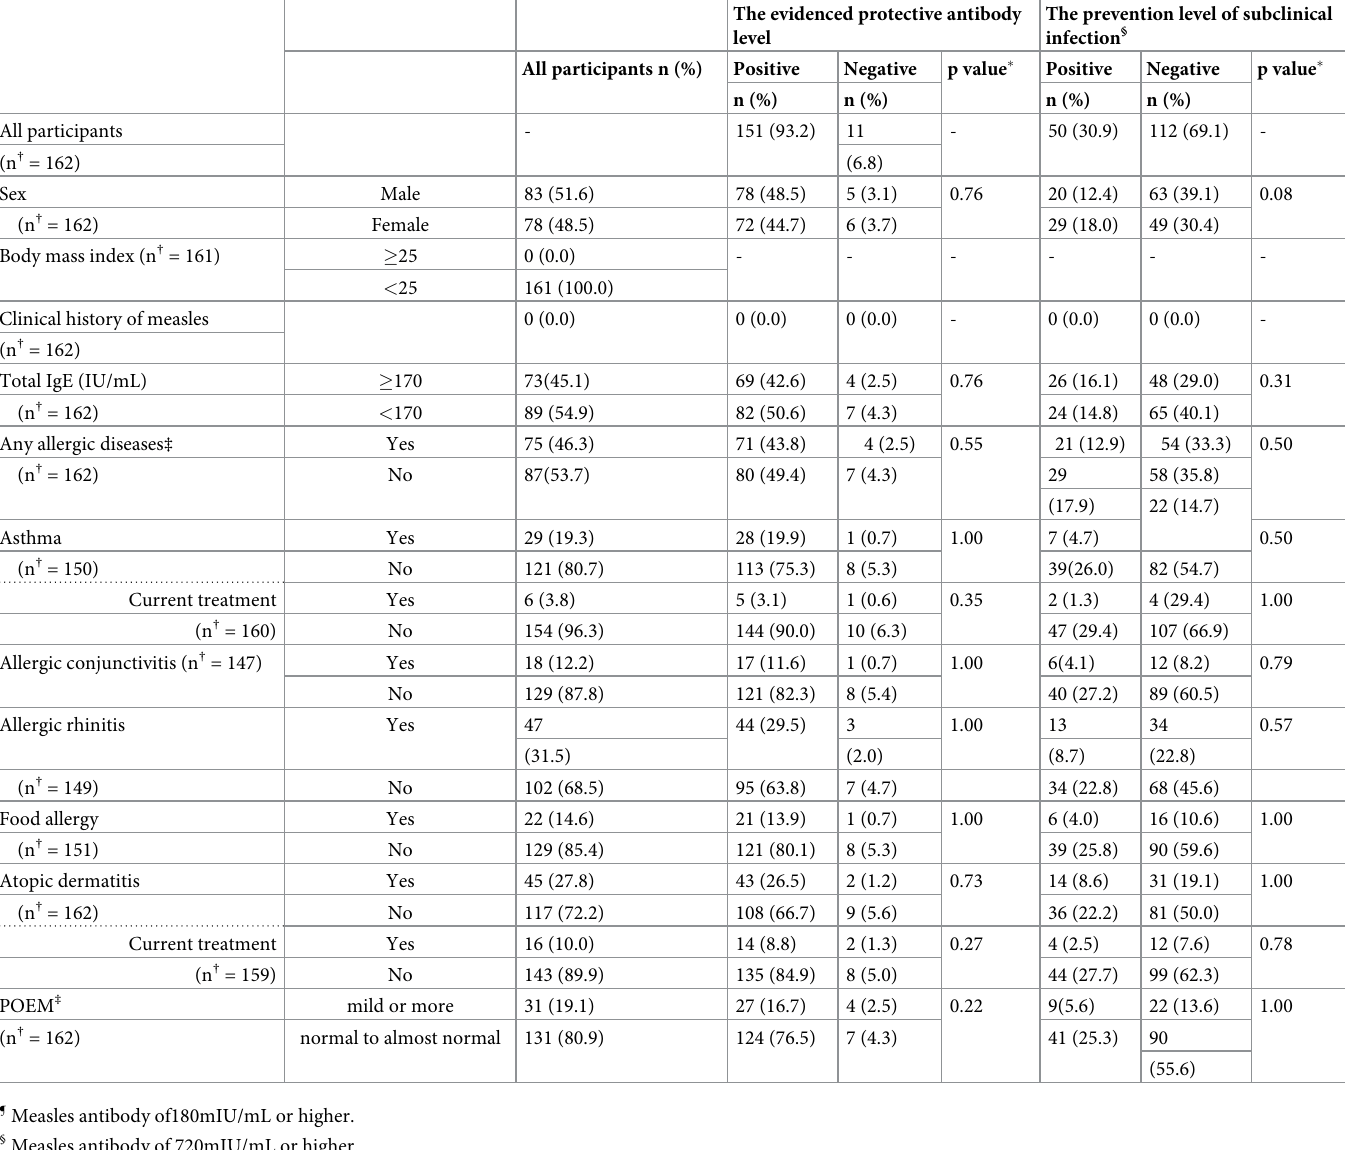
Table 1. The allergic characteristics of the participants and their measles antibody positivity